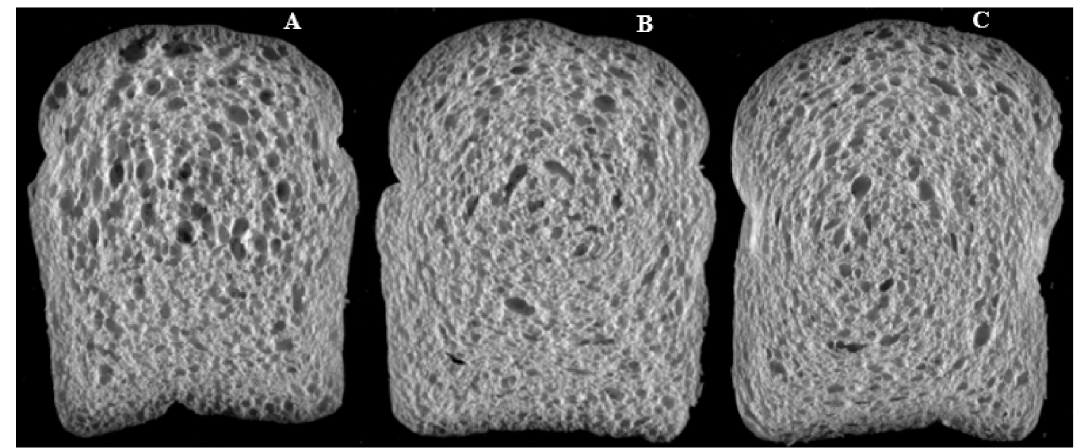
Figure 3. C-cell image of the loaf bread slices. Control–0% SBS ( A ), 1.25% SBS ( B ), and 1.50% SBS ( C ). The crumb structure of the bread slices made from the obtained wheat flours is sum- marized in Table 7. Crumb structures of breads form as the water and alcohols